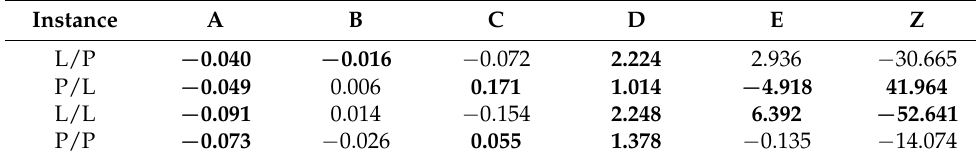
Table 6. Regression equation coefficients.